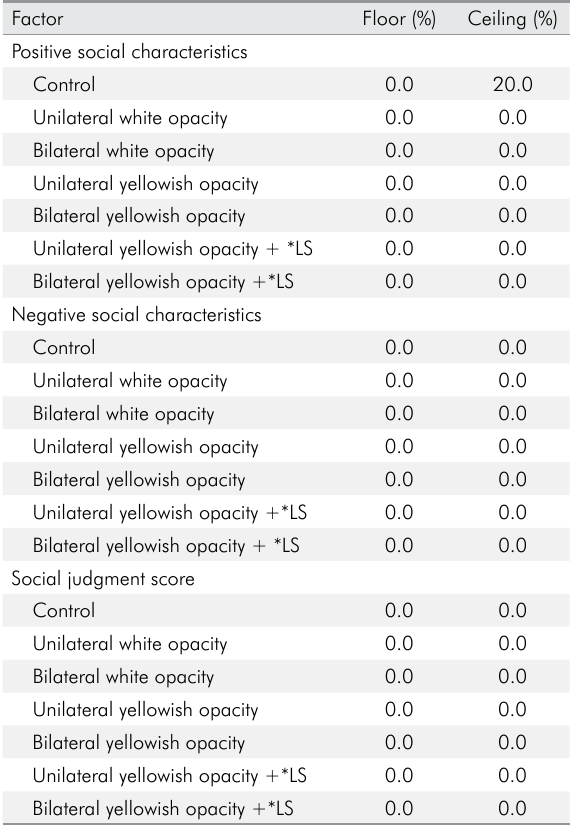
Table 1. Analysis of floor and ceiling effects of social judgment